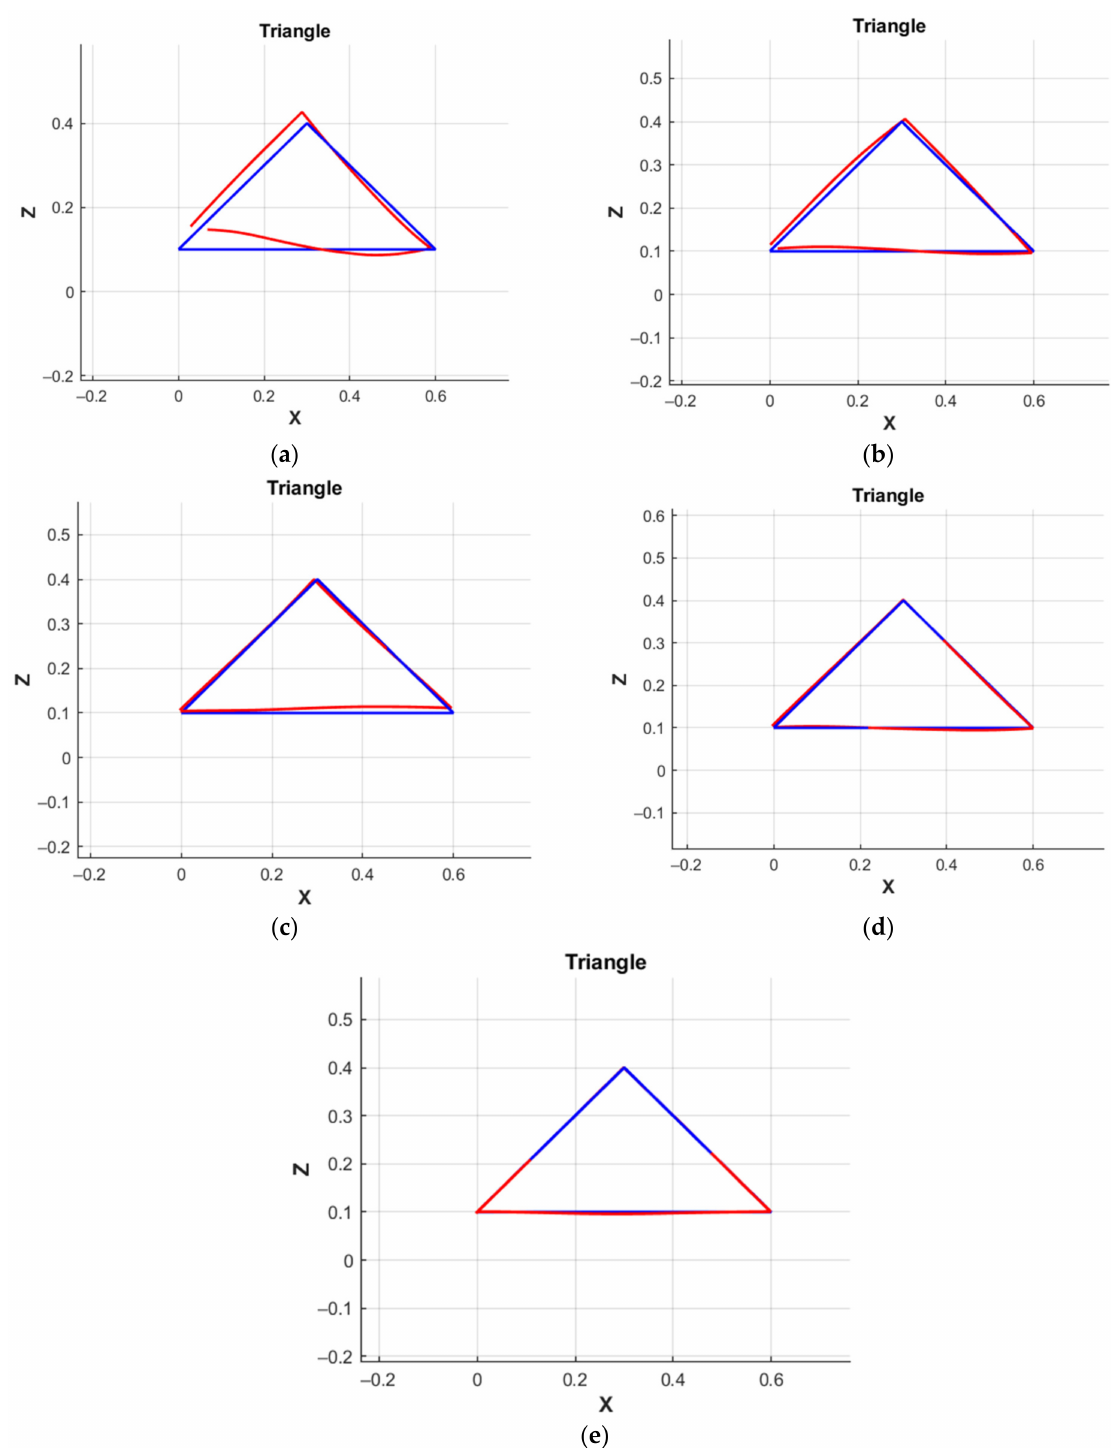
Figure 15. Simulation of the movement of the manipulator along the triangle: ( a ) MATRIX NN 1; ( b ) MATRIX NN 2; ( c ) MATRIX NN 3; ( d ) MATRIX NN 4; ( e ) the correctional